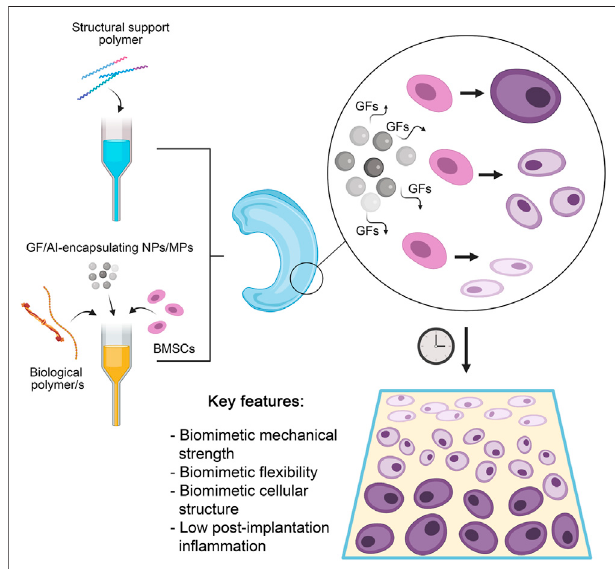
FIGURE 5 | A summary of the most optimal current approach to 3D bioprinting of cartilage structures. A structural support polymer (usually synthetic)ischosenbasedondesiredload-bearingcapabilitiesandco-printed with a range of biological polymers that provide elasticity and a growth medium for seeded cells. Also included are stem cells capable of differentiation into chondrocytes, and nano- (NPs) or microparticles (MPs) encapsulating various growth factors (GFs) toinduce differential differentiation of stem cells and anti-in fl ammatory agents (AIs) to reduce post-implantation in fl ammation. The release of GFs results in a gradual differentiation of seeded stem cells into mature chondrocytes in a strati fi ed manner. The resultant construct has several key features that allows successful clinical